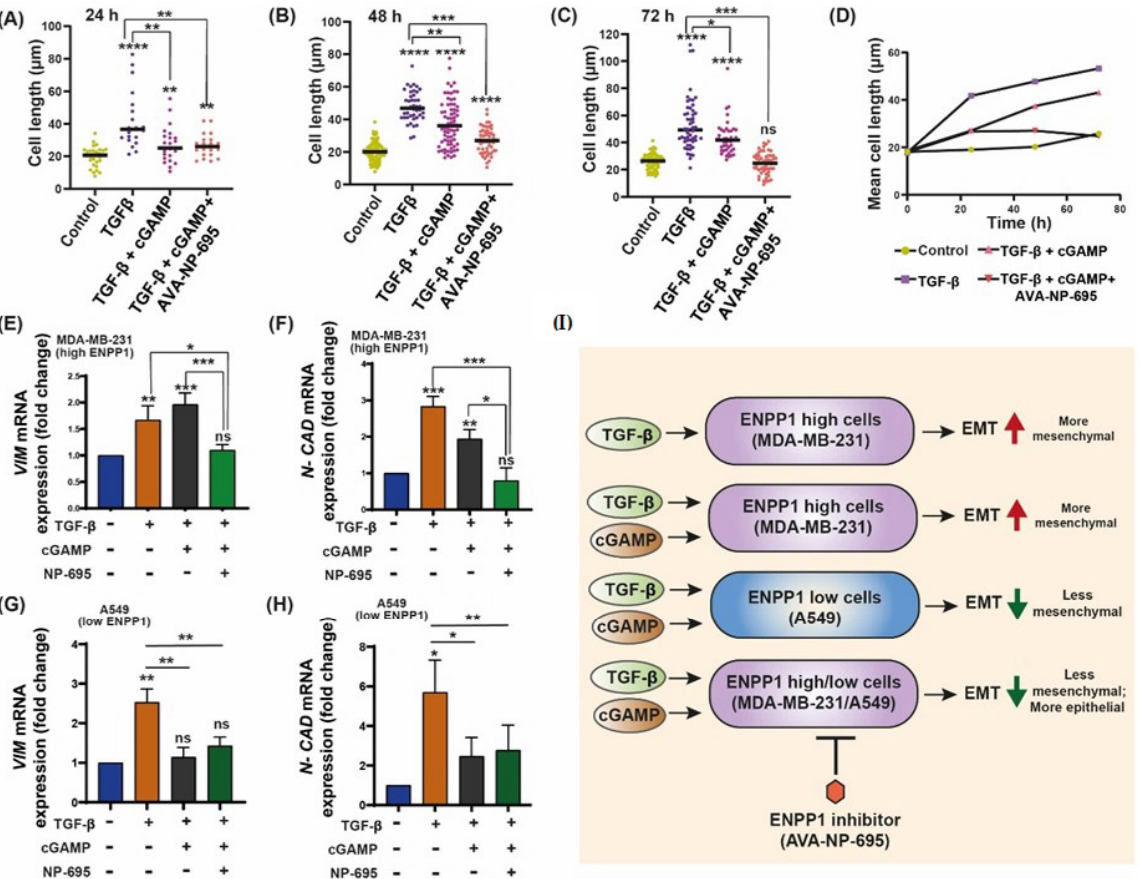
Figure 5. The effect of 2 (cid:48) 3 (cid:48) -cGAMP and TGF- β in the presence of ENPP1 inhibitor on the expression level of EMT markers. ( A – C ) EMT was induced in MDA-MB-231 cells through TGF- β treatment (10 ng/mL) for periods of 24, 48, and 72 h. The cells were consecutively treated with 2 (cid:48) 3 (cid:48) -cGAMP alone and in combination with AVA-NP-695. ( D ) Mean cell lengths with the treatment of TGF- β along with 2 (cid:48) 3 (cid:48) -cGAMP and AVA-NP-695 from each time point and group were plotted. Cell length was analyzed using ImageJ. ( E , F ) The gene expression of VIM and N-CAD was evaluated through real-time PCR and the data were normalized using GAPDH (n = 3). ( G , H ) Low-ENPP1- expressing A549 Dual™ cells were treated with TGF- β , cGAMP, and TGF- β and TGF- β , cGAMP, and AVA-NP-695 for 48 h; VIM ( G ) and N-CAD ( H ) mRNA expression levels were evaluated using RT- PCR (n = 3). ( I ) The schematic representation showing the cumulative conclusion of the experiment. The p -values were calculated with respect to the no-treatment group using ordinary one-way analysis of variance followed by Dunnett’s test. For comparison between two internal groups, Dunnett’s multiple comparison test was performed. *<0.05, ** p < 0.01, *** p < 0.001, **** p <